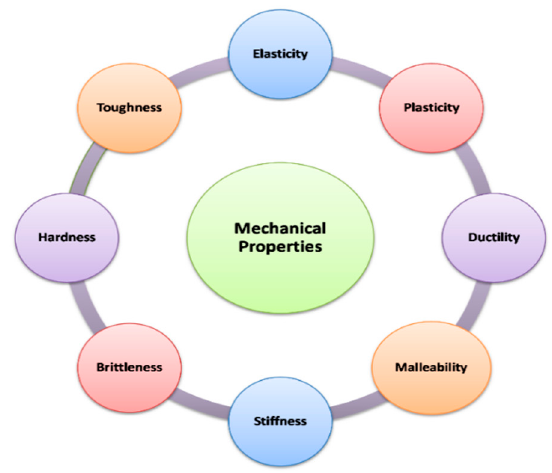
Figure 4. Indicators of mechanical properties of